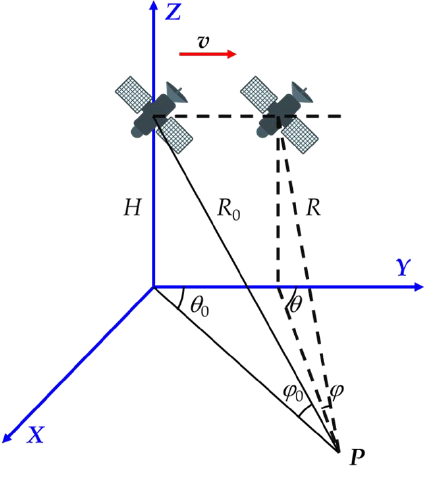
Figure 1. Geometric diagram for forward-looking imaging model.